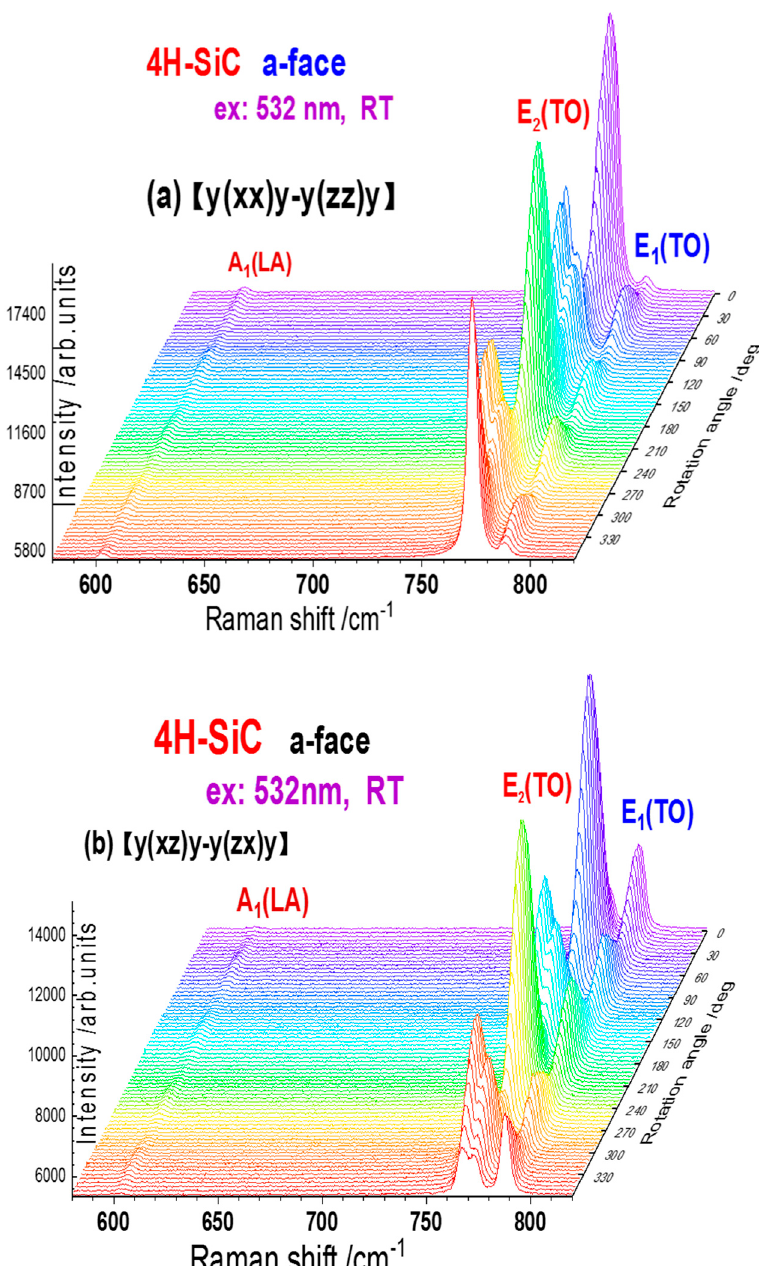
Figure 3. The rotation Raman spectra at the a-plane of 4H-SiC, with the angle varied from 0° to 360° (step size of 5°), under ( a ) parallel and ( b ) perpendicular polarization, respectively.